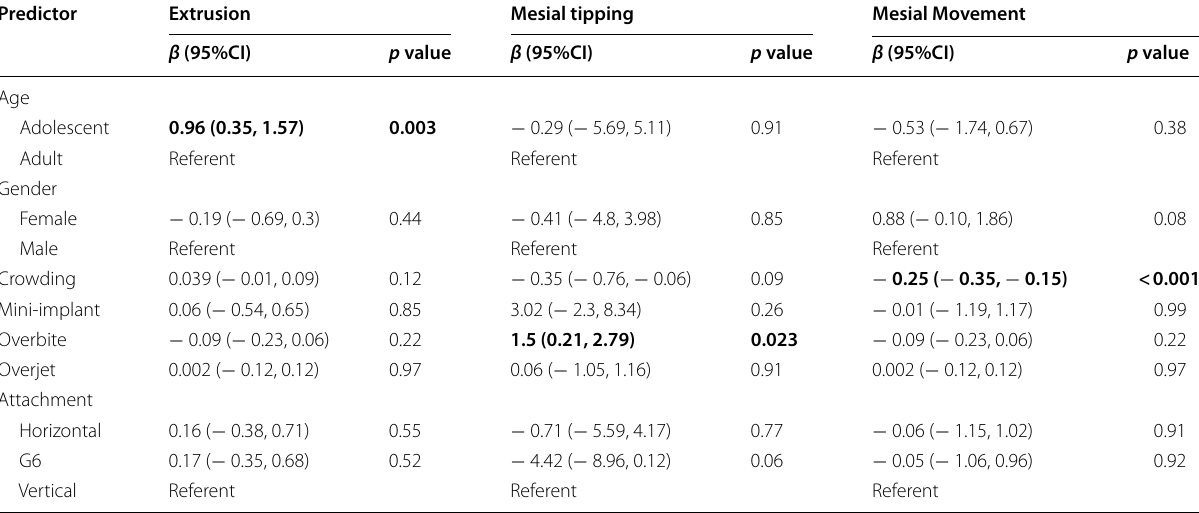
Bold values indicate statistical significance ( p <